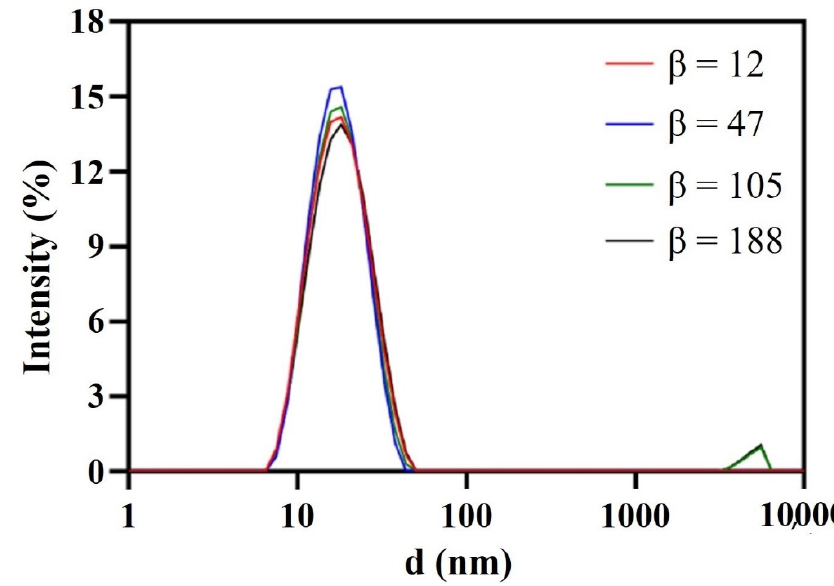
Figure 4. Droplet size distribution of nanoemulsions prepared by RPB with different β .